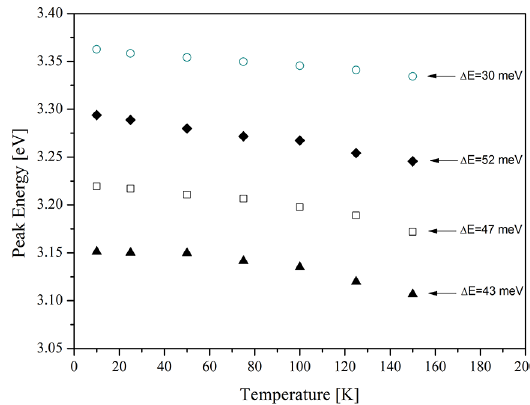
Figure 6. Position of the PL zero phonon line, ZPL, and phonon replica as a function of temperature for the GaN film, at the first focusing